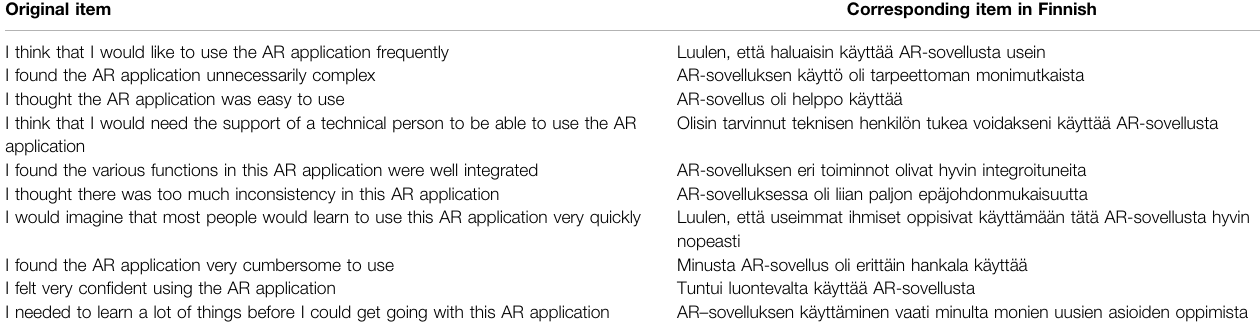
TABLE 2 | SUS items in English and Finnish. Original item